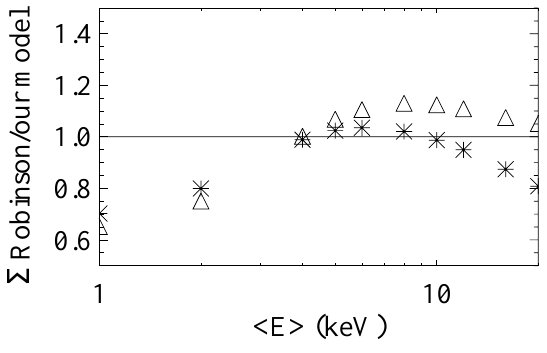
Fig. 3. Ratio between conductances due to electrons calculated with Robinson et al. (1987)’s model and values calculated with this model. The ratio for the Pedersen conductance is presented with stars and the one for the Hall conductance with